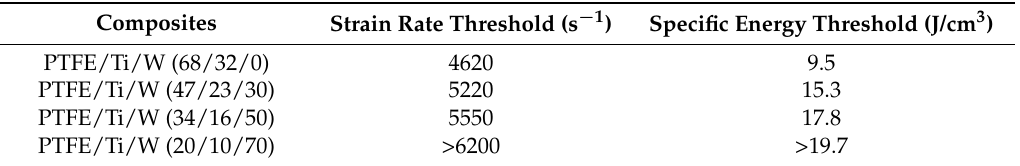
Table 4. Strain rate thresholds and specific energy thresholds of PTFE/Ti/W composites.